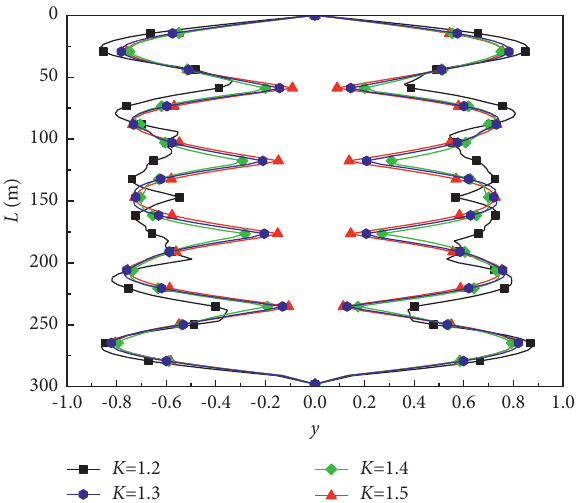
Figure 5: VIV amplitude envelope diagram of the riser under different top tensions.